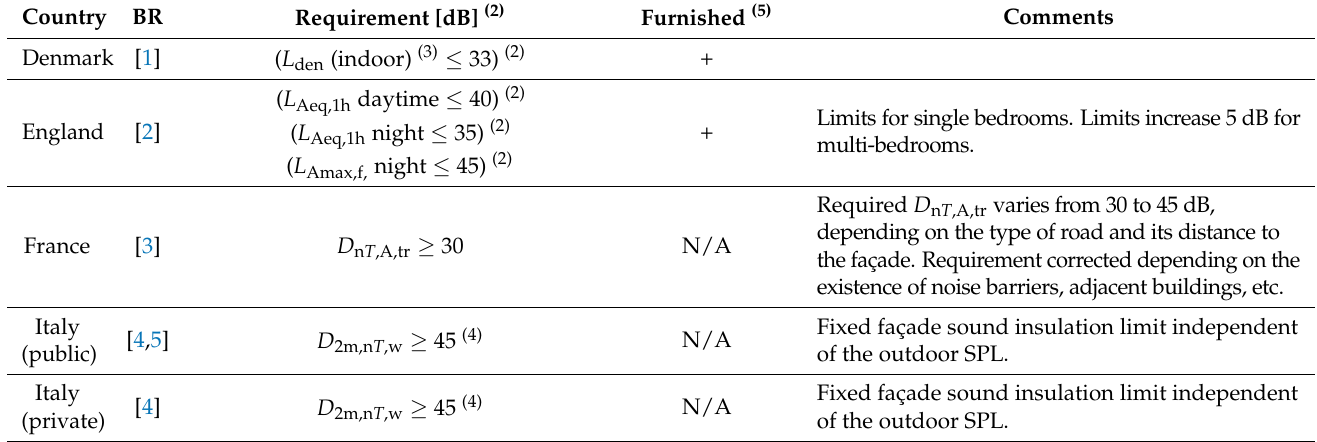
Table 4. Acoustic regulations for hospital bedrooms (1) —Facade sound insulation. November